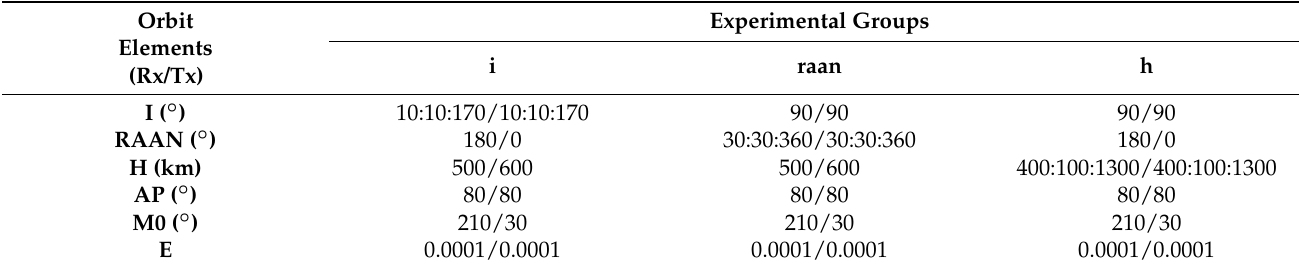
Table 1. The main orbital elements of the transmitting and receiving satellites for a two-satellite experimental constellation. The chosen set of values for some elements is denoted in the format of StartValue:Step:EndValue; simulations were performed using an ensemble of configurations stepping through all value settings for these